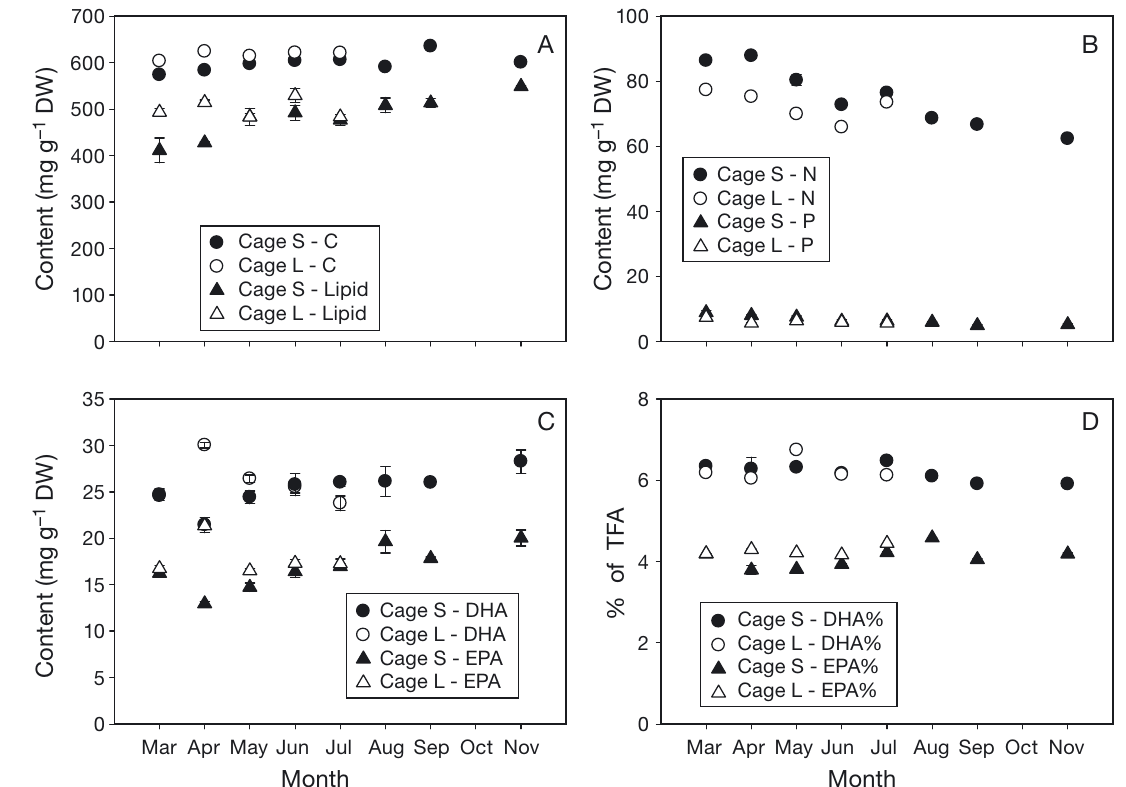
Fig. 5. Chemical contents per gram dry weight (DW) of fish body tissues sampled from Cage S and Cage L. (A) Carbon and lipid content; (B) nitrogen and phosphorus content; (C) docosahexaenoic acid (DHA) and eicosapentaenoic acid (EPA) content; (D) percentage of DHA and EPA in total fatty acid (TFA) content. Error bars show ±1 SE Table 3. Range of chemical content and mean chemical content in fish samples from March to November 2009 (see (Fig. 6B,C) exhibited inverse hyperbolic relationships Fig. 7 for the monthly chemical content for each cage), as with increasing fish wet weight (p < 0.05; Table 3). well as R 2 and p-values for chemical content in fish samples The C, N, P, lipid, DHA and EPA contents of fish as a function of fish wet weight (kg). DW: dry weight; DHA: whole body tissue became constant for large individ- docosahexaenoic acid; EPA: eicosapentaenoic acid; uals, which are in agreement with Moulton (1923). The percentages of DHA and EPA of TFA (Fig. 6G,H) in whole-body samples remained constant and inde- pendent of the fish wet weight (p > 0.05; Table 3). Similar trends were also observed for the relation- ships between chemical contents of fish whole-body tissue and fish length (data not shown).